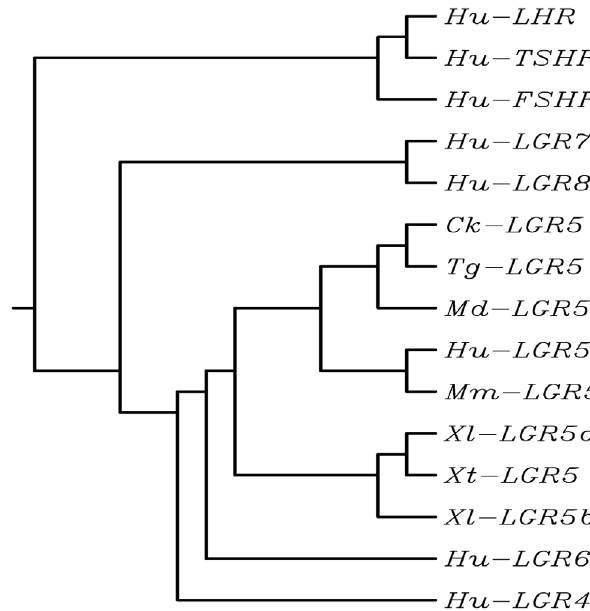
Figure 2. A phylogenetic tree of LGR proteins. Amino acid sequences of indicated LGR proteins were analyzed with Multiple Sequence Alignment by CLUSTALW (http://align.genome.jp/). The proteins form three subgroups: one containing Hu-LHR, Hu-FSHR, and Hu-TSHR; another containing LGR7 and LGR8, whose ligands are small heterodimeric peptides with homology to insulin, including the pregnancy hormone relaxin and insulin-like 3 [33,34,35]; and the third containing LGR4, LGR5, and LGR6, including the X. laevis LGR5a, b as well as X. tropicalis LGR5, and LGR6. Hu, human, Ck, chicken, Tg, Taeniopygia guttata , Md: Monodelphis domestica.